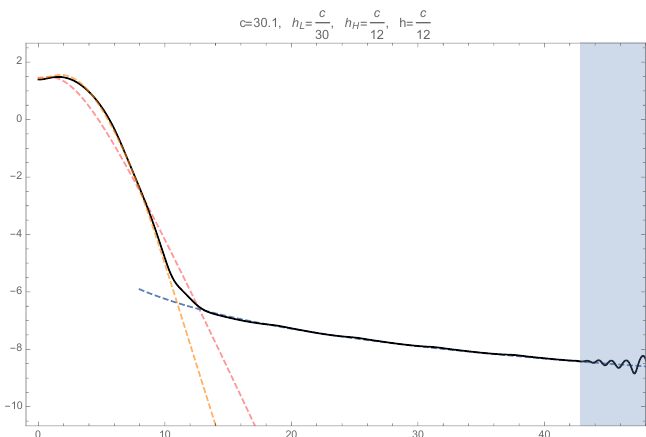
Figure 20 . This (cid:12)gure corresponds to the top-right plot of (cid:12)gure 10, but includes a match to the semiclassical blocks obtained using the methods of [5], which allow for h; h L dashed line is the approximation of equation (2.10), which assumes h; h L a much less reliable (cid:12)t for these parameter values.